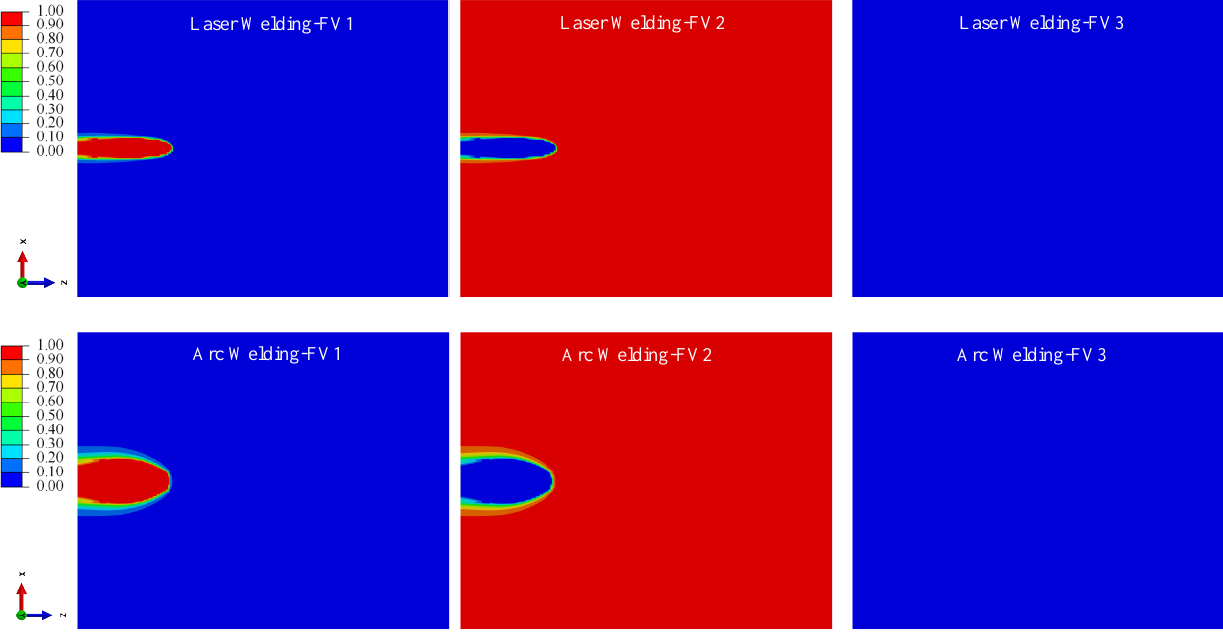
Figure 18. With the heat source moving to 25 mm from starting position, change of volume fraction of phase composition in weld bead.